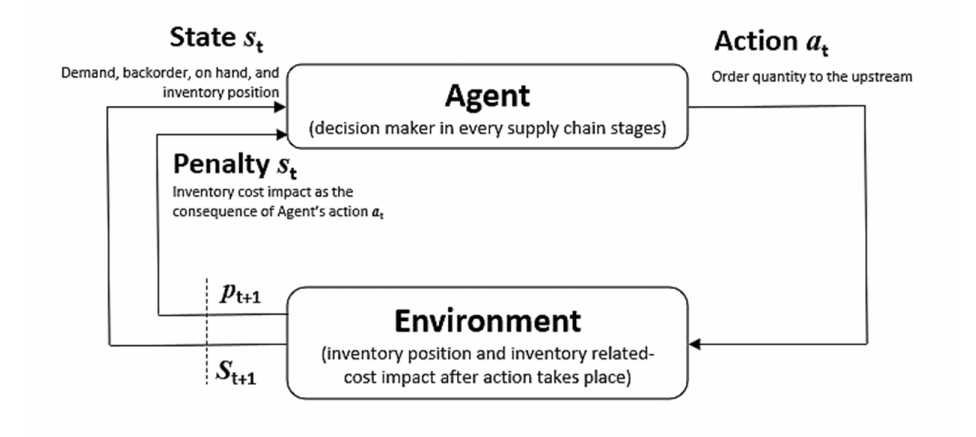
Fig. 1 Key Element Interaction of RL